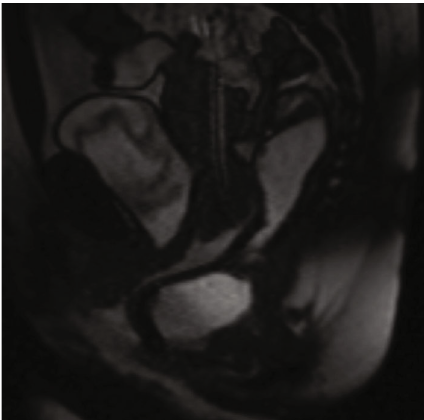
Figure 3: MR defecography demonstrates severe ( > 6cm) anorectal junction descent during maximal strain. Severe ( > 4cm) posterior vaginal wall prolapse is also noted. Of note, the patient did not defecate during the